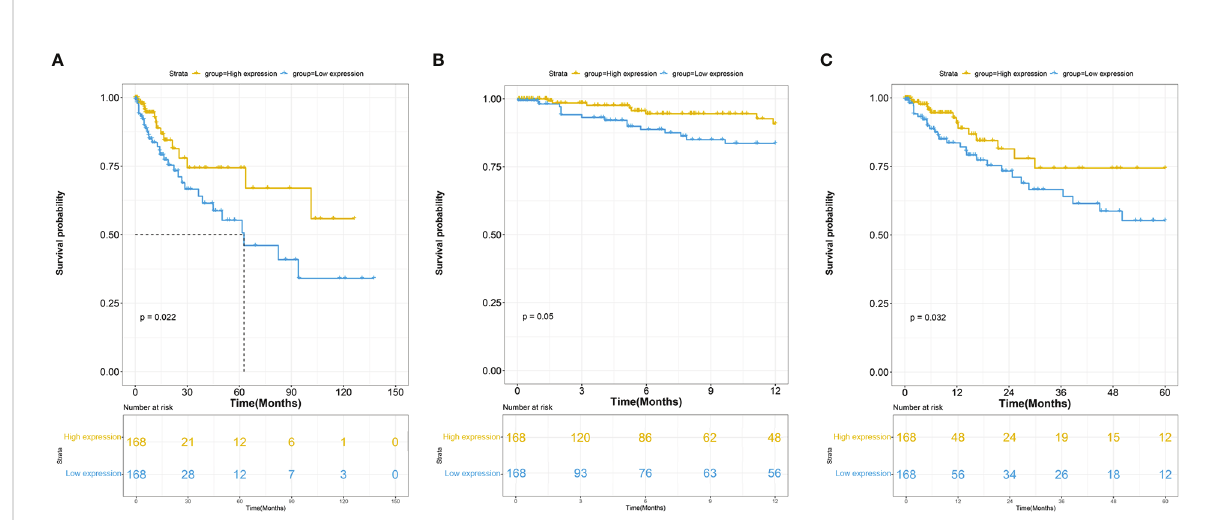
FIGURE 2 (A) Overall survival (OS) of COAD patients grouped by ITG b 3 median cutoff in TCGA; one-year (B) and fi ve-year (C) OS in comparison between high- and low-ITG b 3